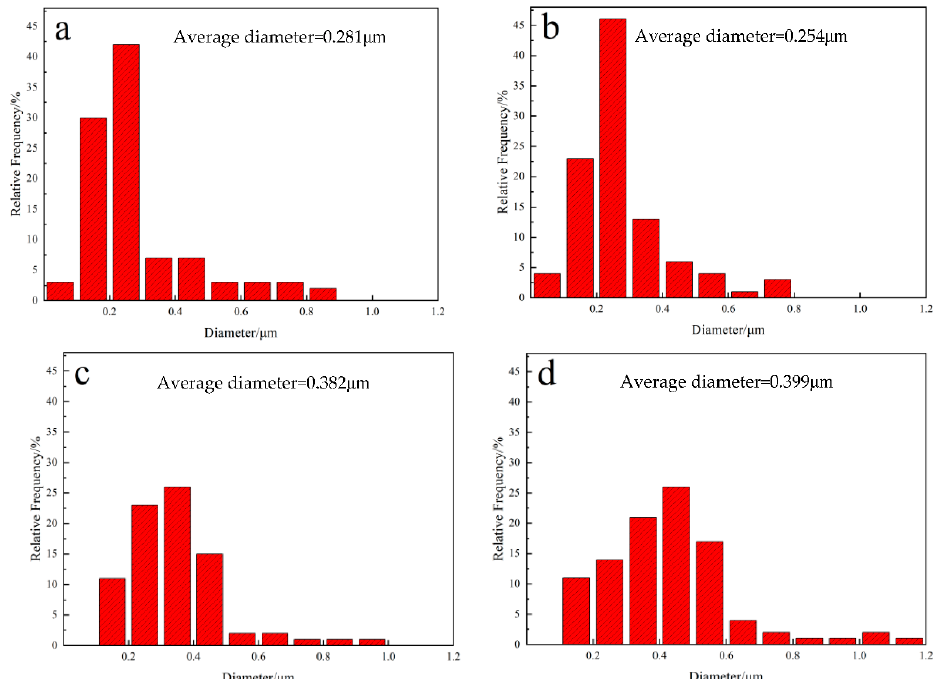
Figure 12. SEM images at different addition of FeCl 3 ·6H 2 O: ( a ) the addition of 0.4 wt%; ( b ) the addi- tion of 0.8 wt%; ( c ) the addition of 1.2 wt%; ( d ) the addition of 1.6 wt%.